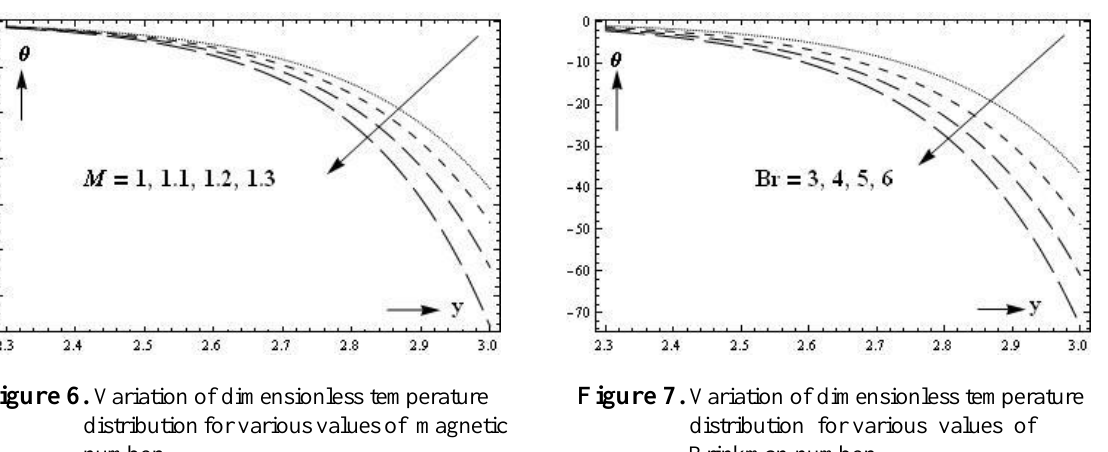
Figure 6. Variation of dimensionless temperature distribution for various values of magnetic number .